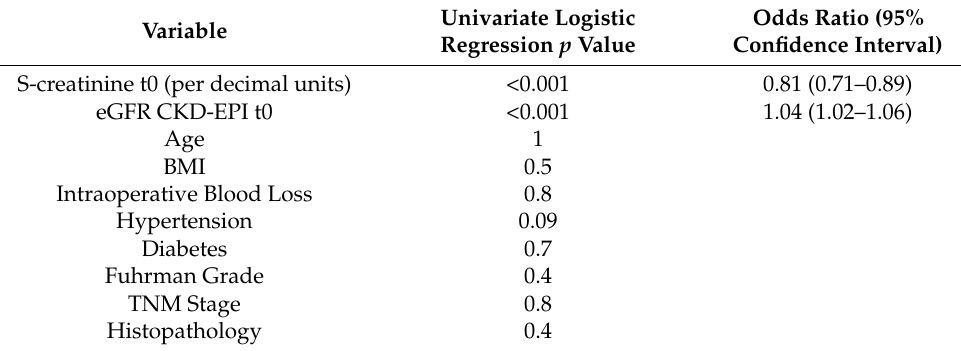
Table 2. Univariable logistic regression for AKI onset. Univariate Logistic Odds Ratio (95% Variable Confidence Interval) S-creatinine t0 (per decimal